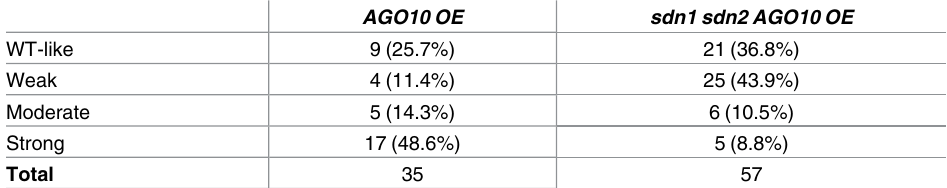
Table 1. sdn1 sdn2 partially suppresses the developmental phenotype of AGO10 OE . AGO10 OE sdn1 sdn2 AGO10 OE WT-like 9 (25.7%) 21 (36.8%) Weak 4 (11.4%) 25 (43.9%) Moderate 5 (14.3%) 6 (10.5%) Strong 17 (48.6%) 5 (8.8%) Total 35 57 Developmental phenotypes of the primary AGO10 OE transformants were classified into four categories: wild type—like, Weak, Moderate, and Strong, based on the degree of deviation from the wild-type leaf phenotype. Thirty-five primary AGO10 OE transformants in wild-type background and 57 AGO10 OE transformants in the sdn1 sdn2 background were analyzed. Abbreviations: WT, wild